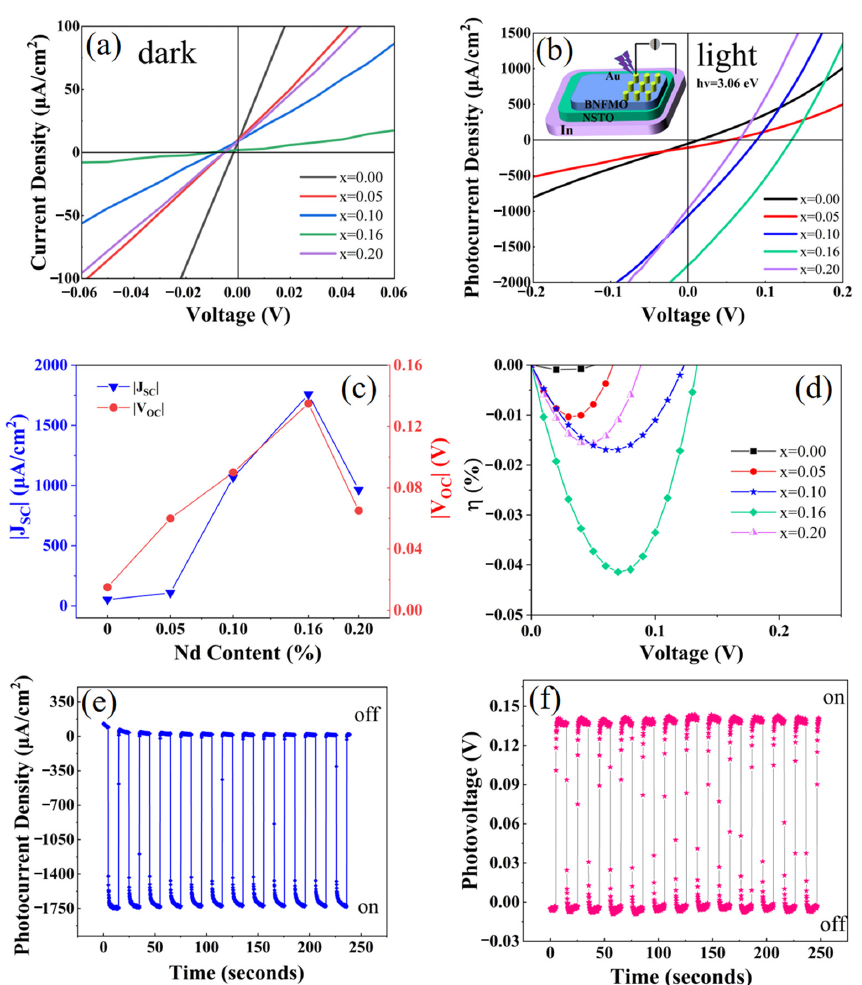
Figure 7. ( a ) J–V curves of ferroelectric photovoltaic devices in darkness. ( b ) J–V curves of ferroelectric photovoltaic devices under illumination. The inset shows the Au/BNFMO (x = 0.00~0.20)/NSTO/In structure diagram of the ferroelectric photovoltaic device. ( c ) The change in the J SC and V OC with Nd-doping amount. ( d ) Corresponding voltage dependence of light-to-electricity power conversion efficiency ( η ) for BiFe 0 . 99 Mn 0 . 01 O 3 film with different Nd 3+ contents. ( e , f ) The time dependence of the photocurrent density and photovoltage of Bi 0 . 84 Nd 0 . 16 Fe 0 . 99 Mn 0 . 01 O 3 . The Nd-doping not only reduces the dark current density but also raises the photo- current density, and the Bi 0 . 84 Nd 0 . 16 Fe 0 . 99 Mn 0 . 01 O 3 thin film exhibits a more than 35-fold enhancement compared with the BFMO film, indicating that the ferroelectric photovoltaic effect is regulated by the ferroelectric polarization. The photocurrent densities of BNFMO (x = 0.00~0.20) films are − 52, − 108, − 1067, − 1758, and − 964 µ A/cm 2 , while the photovoltages are 0.020, 0.050, 0.090, 0.135, and 0.065 V, respectively. Figure 7c demonstrates the change in the J SC and V OC with Nd-doping amount. The power conversion efficiencies ( η = P out /P in = JV/P in ) at the point (J, V) of the BNFMO films are shown in Figure 7d. To verify the reliability of the ferroelectric photovoltaic phenomenon, we measured the time depend- ence of the photocurrent density and photovoltage of Bi 0 . 84 Nd 0 . 16 Fe 0 . 99 Mn 0 . 01 O 3 film by con- trolling the light source to turn on and off alternately every 12.5 s, as shown in Figure 7e,f. Obviously, there is no attenuation of the photocurrent density and photovoltage during several cycles. In addition, it should be noted that our experimental results are numeri- cally much larger in short-circuit current compared to reported literature results of Nd-